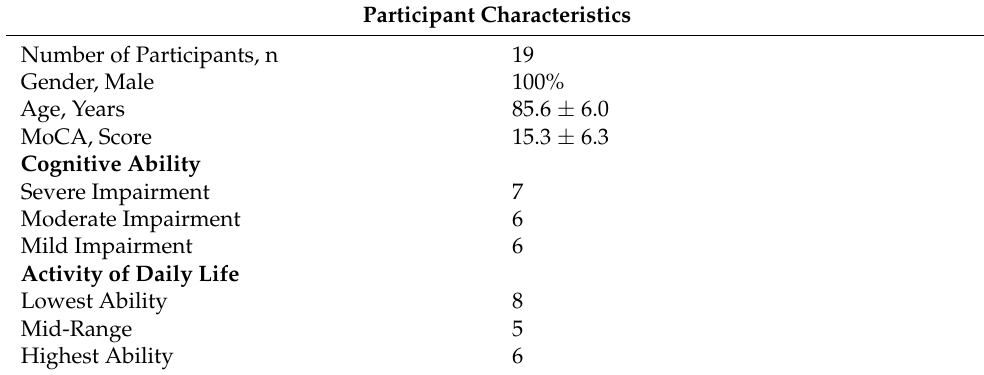
Table 1. Demographic information.